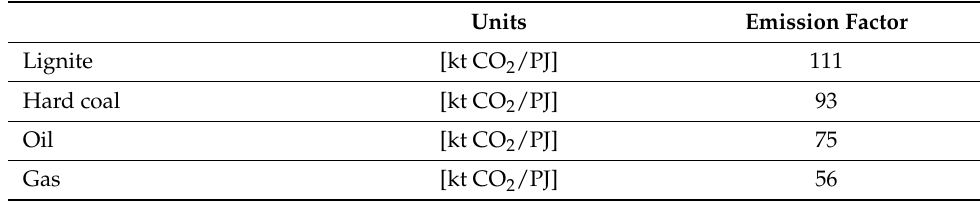
Table 21. Emission factors used for the OECM 1.5 ◦ C pathways.